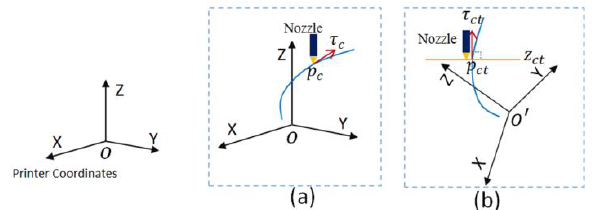
Figure 9. Schematic diagram of model space rotation: ( a ) transform before and ( b ) transform after.